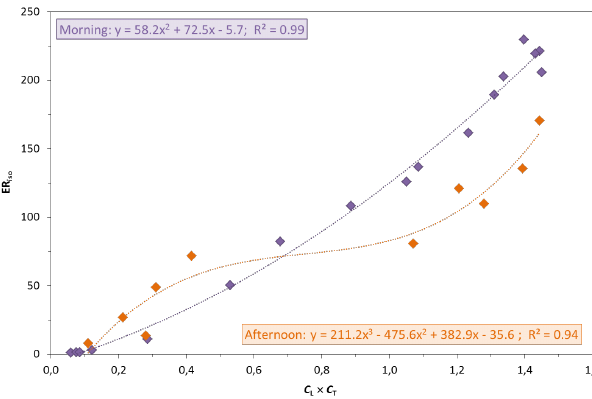
Figure 5. Diurnal variations of Qp 4 isoprene emission rates ER iso (µgCg − 1 h − 1 ) ± SD vs. the corresponding net photosynthetic as- DM similation Pn (µmolCO 2 m − 2 s − 1 ) , PAR (µmolm − 2 s − 1 ) , temper- ature T ( ◦ C) and C L and C T parameters (as in Guenther et al., 1993).